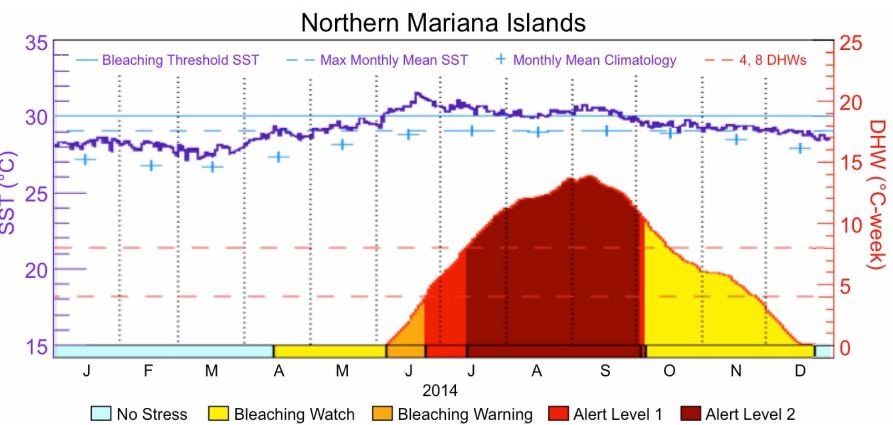
Figure 2. Regional Virtual Station time series for CNMI in 2014. The purple SST trace is the temperature at the location of the 90th percentile HotSpot value from among 5 km pixels for CNMI (see Figure 1b) for each date. Similarly, the red DHW trace is the 90th percentile DHW value and the color under this trace reflects the 90th percentile Bleaching Alert Area value. For each pixel, DHW accumulates when the SST value exceeds the maximum (blue dashed, MMM) of the monthly mean climatology values (cid:5) (blue plus) by at least 1 C (blue solid, Bleaching Threshold)—the time series shows the spatial average (cid:5) of each of these values. DHW thresholds of 4 and 8 C-weeks (red dashed) have been associated with significant coral bleaching, and widespread bleaching and significant mortality,